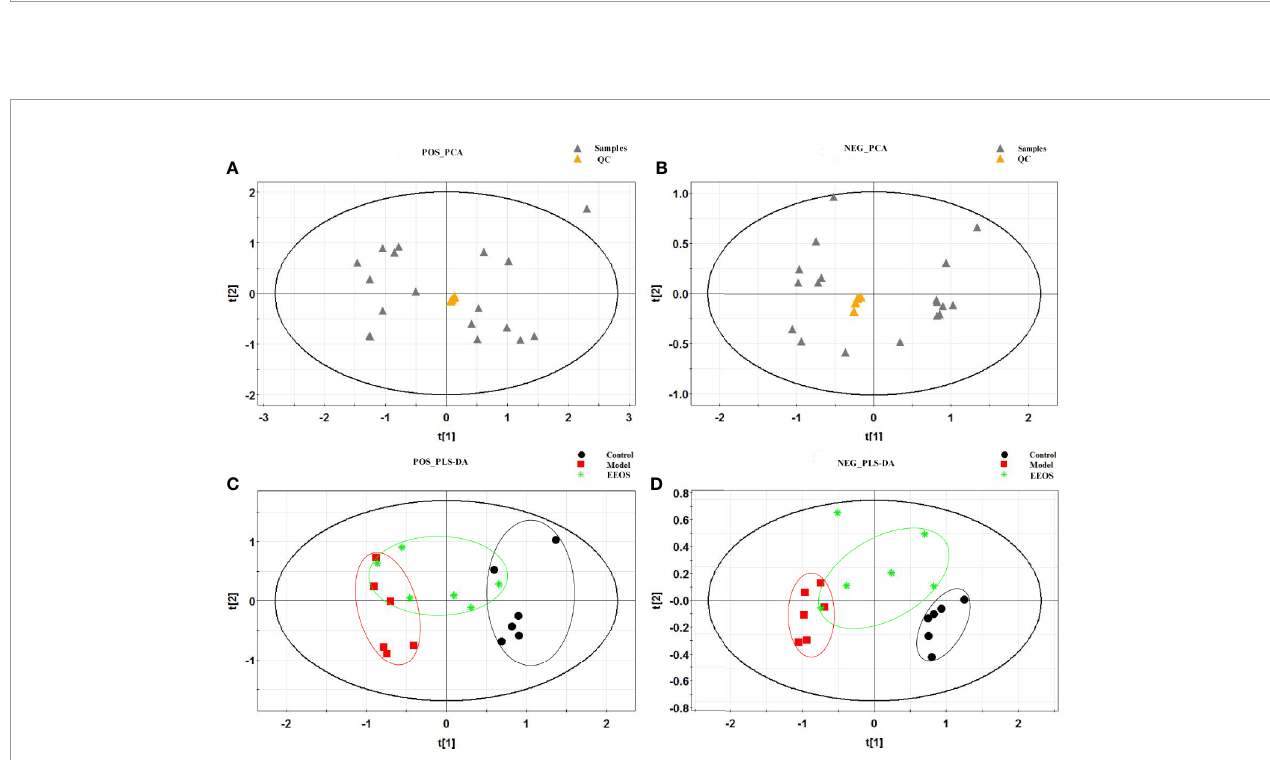
FIGURE 3 | Multivariate statistical analysis score plots of three groups by in positive and negative ion modes. (A) Principal component analysis (PCA) score plot for all samples in positive mode, the quality control (QC) samples polymerized well; (B) PCA score plot for all samples in negative mode, the QC samples also polymerized well; (C) partial least squares discriminate analysis (PLS-DA) score plot in positive mode for control group, model group and EtOAc extract of OS (EEOS) group, the separation between the control group and the model group is obvious, and EEOS group has a tendency to rehabilitate from model group; (D) PLS-DA score plot in negative mode for control group, model group and EEOS group, there is good separation between control and model groups, and EEOS group has a tendency to recover to control group.